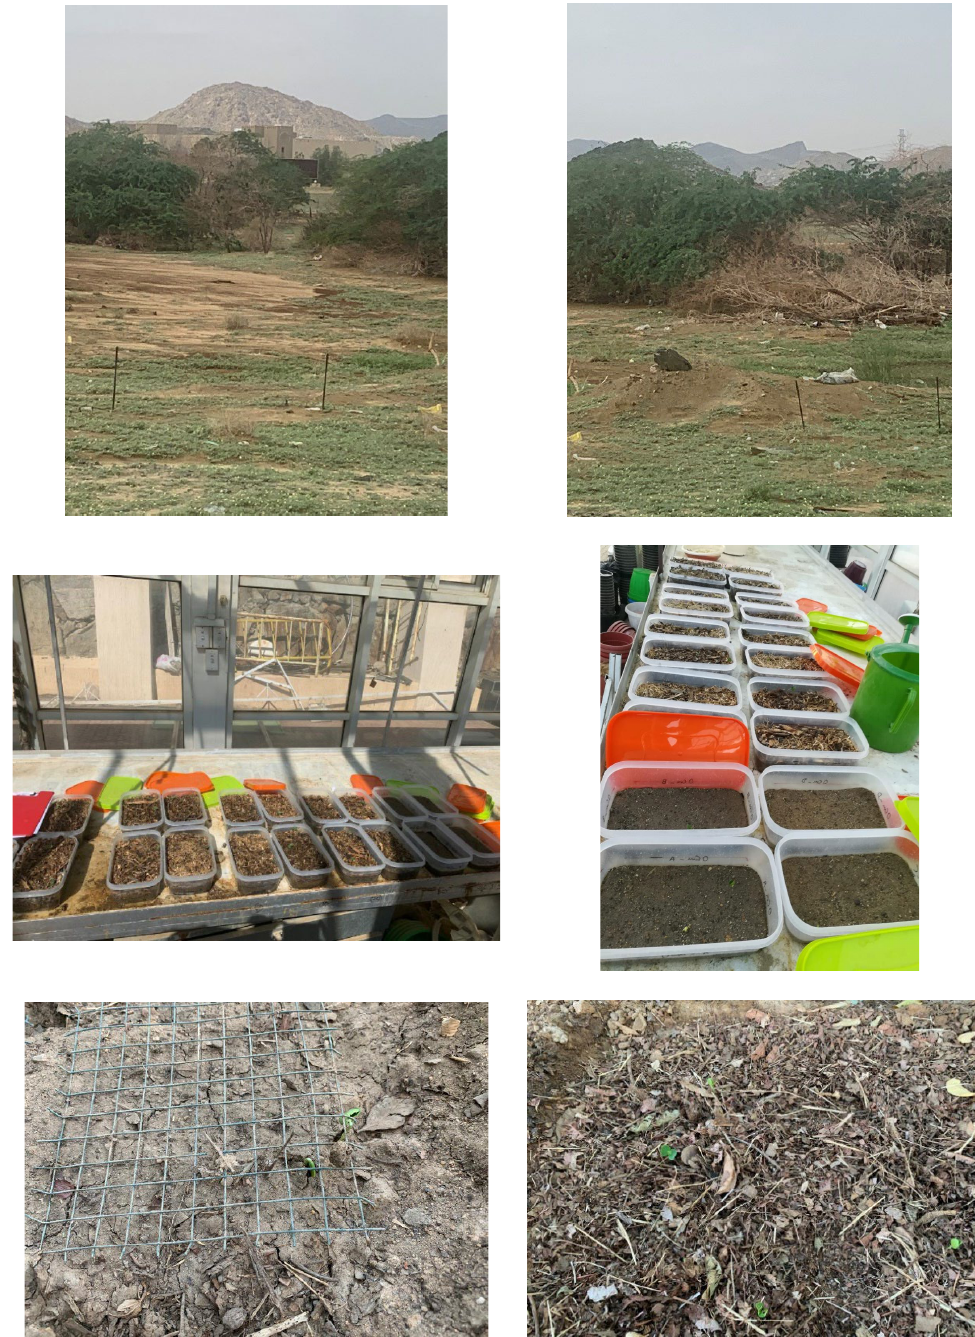
Figure 4. Photographs of Prosopis juliflora and the greenhouse and field experiments conducted in this study. The top two photos show Prosopis juliflora from Wadi Qaradah, Southwest Saudi Arabia. The two photos in the middle of this figure show the set-up of the greenhouse experiment (see the text for a further explanation). The bottom two photos show the setup of the field experiment ( left ) and the field plots with a litter layer and Prosopis juliflora seedlings that have emerged from the litter ( right ).